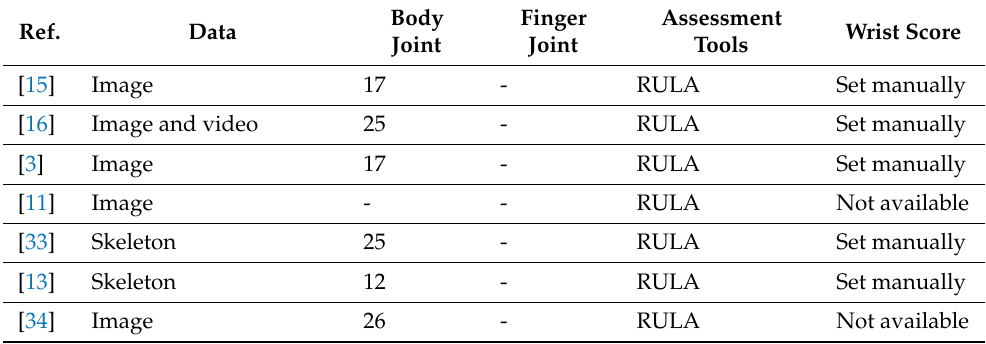
Table 1. List of Related